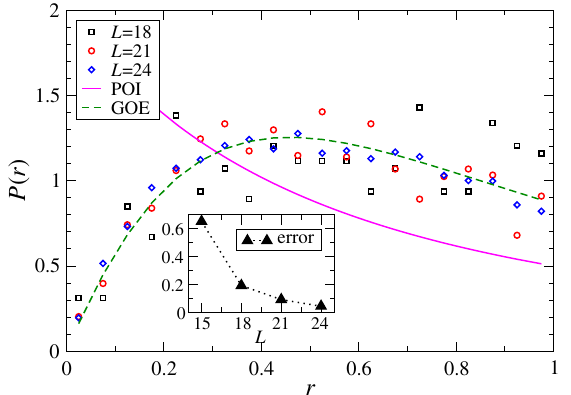
FIG. 1. Probability distribution P ð r Þ for the ratio of two consecutive energy gaps in the spectrum of Eq. (12)] together with the GOE and POI predictions. (Inset) The error distance between P ð r Þ and the GOE prediction decreases quickly with an increasing system